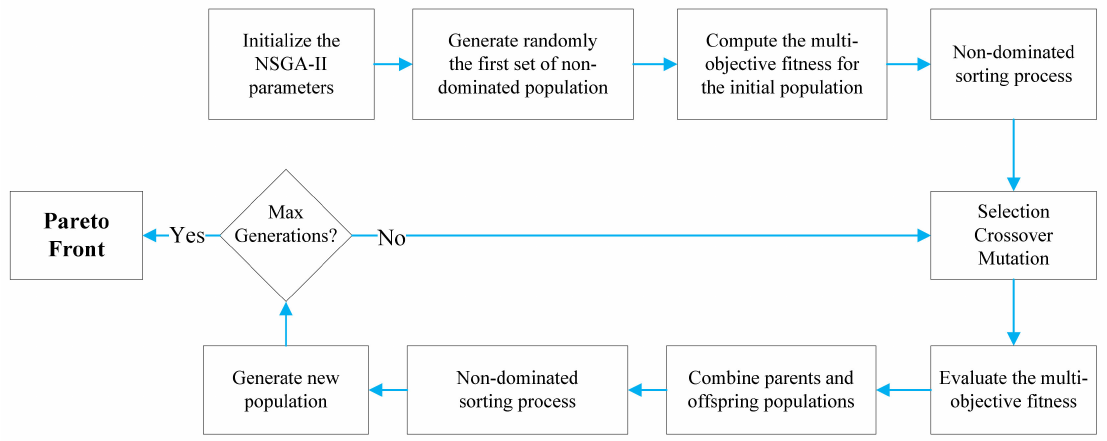
Figure 8. Schematics of multi-objective optimization